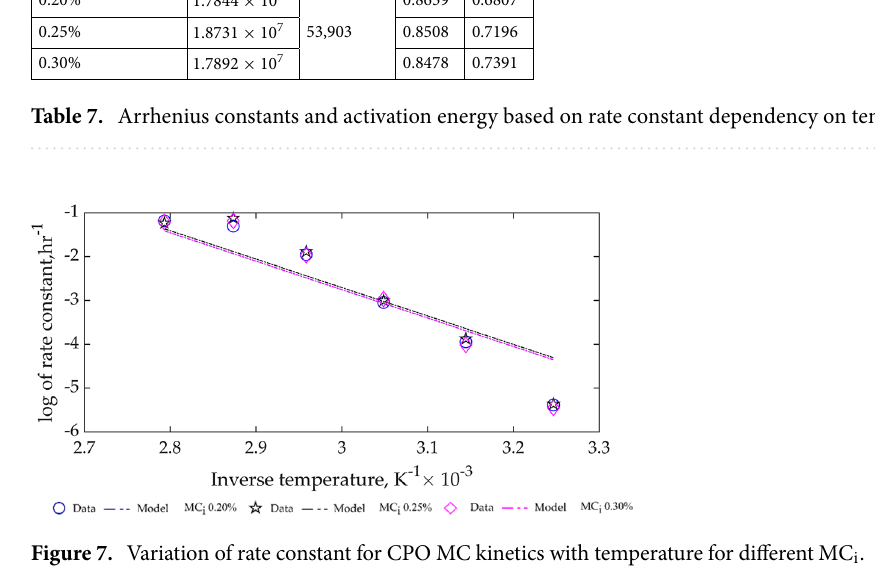
Figure 7. Variation of rate constant for CPO MC kinetics with temperature for different MC i